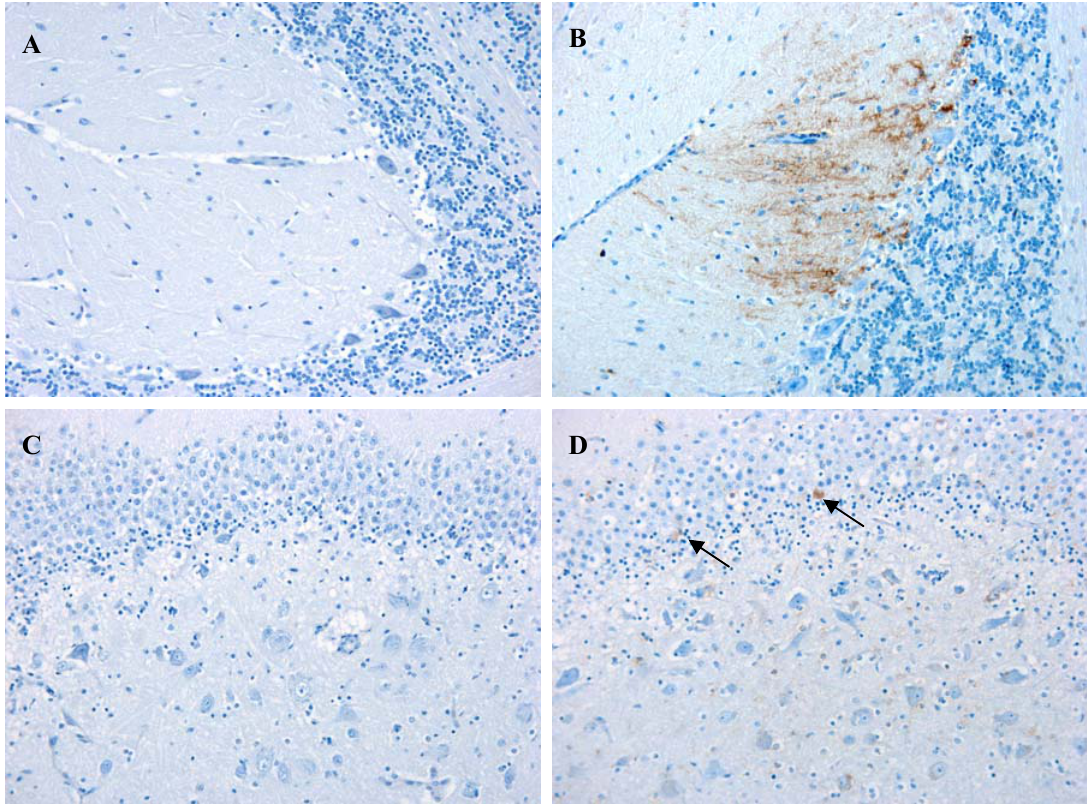
Figure 3. Staining for rabies virus nucleoprotein antigen in the cerebellum ( A & B ) and hippocampus ( C & D ) of a normal dog ( A & C ) and the RABV infected dog ( B & D ). Immunohistochemical detection (brown staining) was observed in Purkinje cells (perikaryon and cell processes) and in a few ganular cell layer neurons ( B ). A small number of immunolabelled neurons (arrows) are present in the hippocampus ( D ). All images were taken at a magnification of